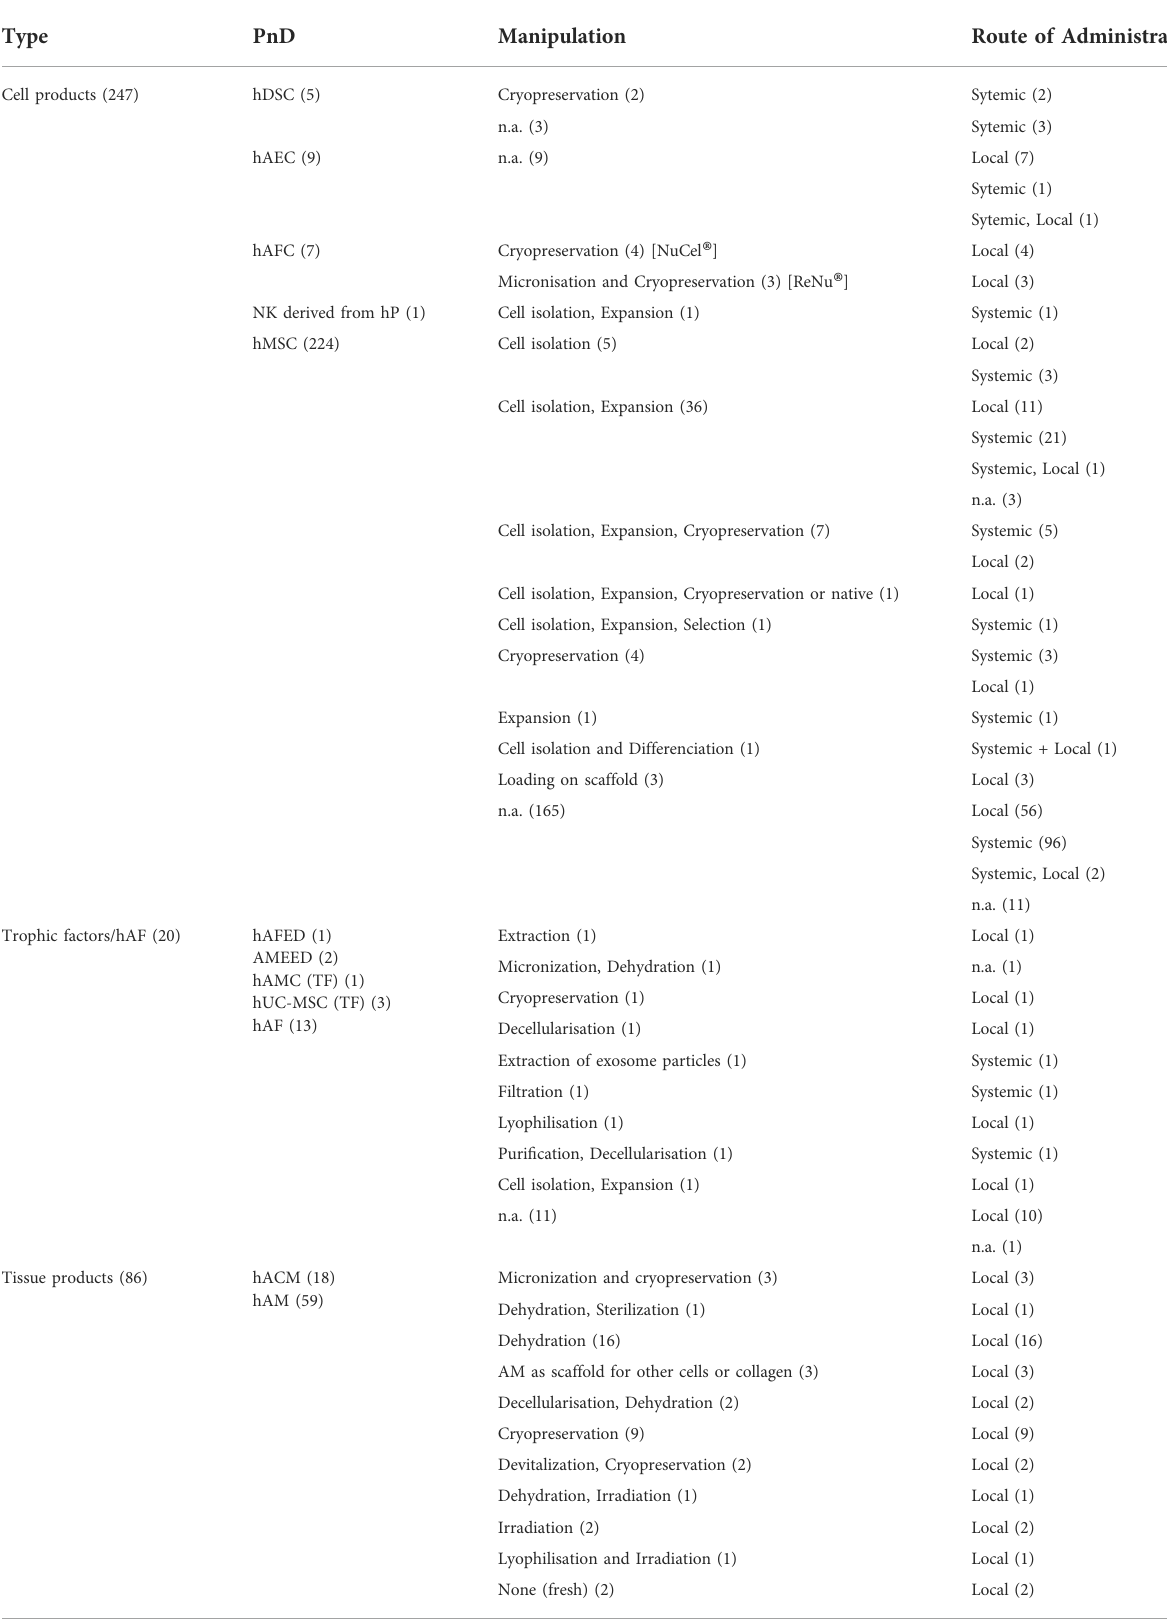
TABLE 4 Distribution of different manipulation and corresponding route of administration among